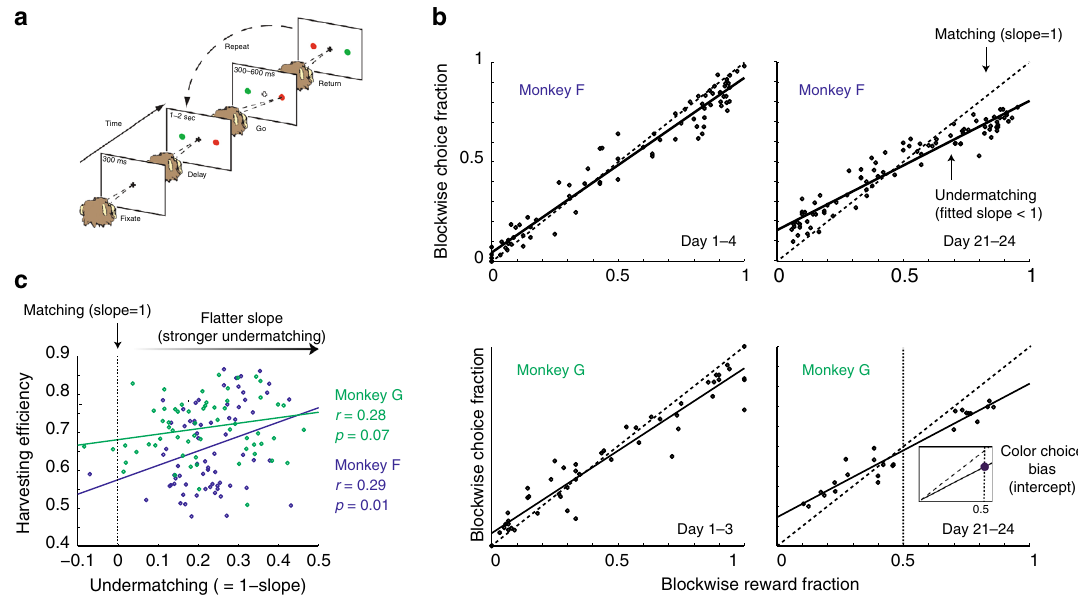
Fig. 1 Task and behavior. a Behavioral protocol (adapted from 18 ): the animal had to fi xate the central cross, and after a short delay (Delay), it could make a saccadic eye movement toward one of the color targets (Go). If the chosen target was baited, a drop of water was delivered (Return). A delivery of reward resets the target to be empty, until it is baited again, which was stochastically determined with different baiting rates for different targets. The sum of baiting rates for two targets was set at ~0.35 rewards per trial. The relative baiting rates changed at the end of blocks (about every 100 trials) with no signal. The Ratio of baiting rates in each block was chosen unpredictably from the set (8:1, 6:1, 3:1, and 1:1). In this setup if the ratio is fi xed, the matching law is known to approximate the optimal stochastic choice behavior. b Deviation from the matching law: the fraction of choices allocated to one target is plotted as a function of the fraction of rewards that were obtained from the same target for different experimental days (top left Monkey F days 1 – 4, bottom left: days 21 – 24, top right Monkey G days 1 – 3, bottom right: days 21 – 24). Each data point represents an estimate in a given block of trials, the solid line is a linear fi t to the data. The matching law corresponds to a line with a slope equal to 1 (dashed line), while the observed behavior, with a slope <1, is called undermatching. Undermatching indicates that animals had a tendency to explore choices more (or, put simply, appear to be more random) than what the matching law would predict. For both monkeys the behavior deviates from the matching law, and the degree of undermatching (measured by the slope) changes over time. Note that undermatching is different from color choice bias, which is indicated by the fi lled circle in the inner panel (bottom right). The color choice bias is de fi ned by the intercept of the fi tted matching slope and the reward fraction of 0.5. c Paradoxically, the harvesting ef fi ciency, which indicates how well the monkeys collected rewards, positively correlates with the degree of undermatching: the more choice behavior deviates from the matching law, the higher the harvesting ef fi ciency. The harvesting ef fi ciency is de fi ned as the number of rewards that monkeys actually obtained divided by the maximum number of rewards that could have been collected. Hence it varies between 0 and 1. The monkeys almost always undermatched, the degree of which shows a wide distribution over